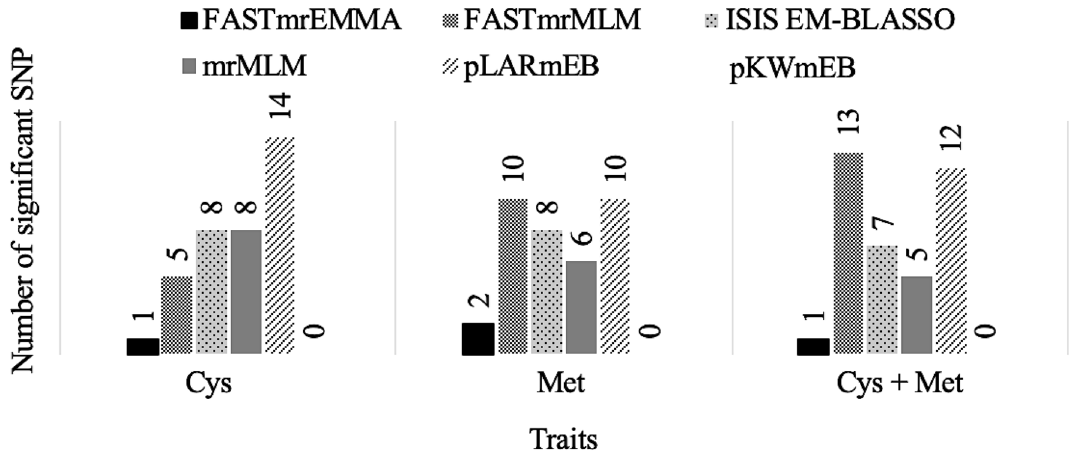
Figure 4. Total number of significant SNPs detected using six multi-locus